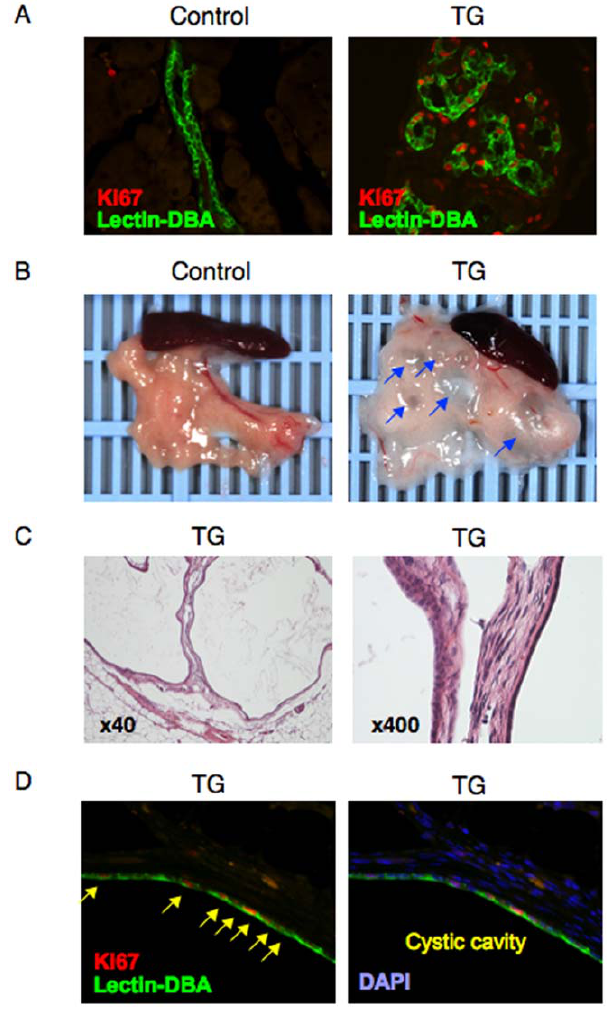
Figure 3. Enhanced proliferation of pancreatic duct epithelial cells and development of polycystic pancreas in TG mice. (A) Immunohistochemistry with anti-Ki67 antibody (red) along with Lectin- DBA (green) was conducted in pancreatic sections from 2 month old TG and control mice. Representative results are shown. (B) Photographs of the pancreas in 12 month old TG and control mice. Representative pictures are shown. (C) Hematoxylin and eosin (HE) staining (left panel indicates 6 40 magnification and right 6 400) in pancreatic sections from 12 month old TG mice. Representative images are shown. (D) Immunohistochemistry with anti-Ki67 antibody (red) along with Lectin-DBA (green) was conducted in pancreatic sections from 12 month old TG mice. Representative images of pancreatic cysts are shown. Arrow indicates Ki67 positive cells.